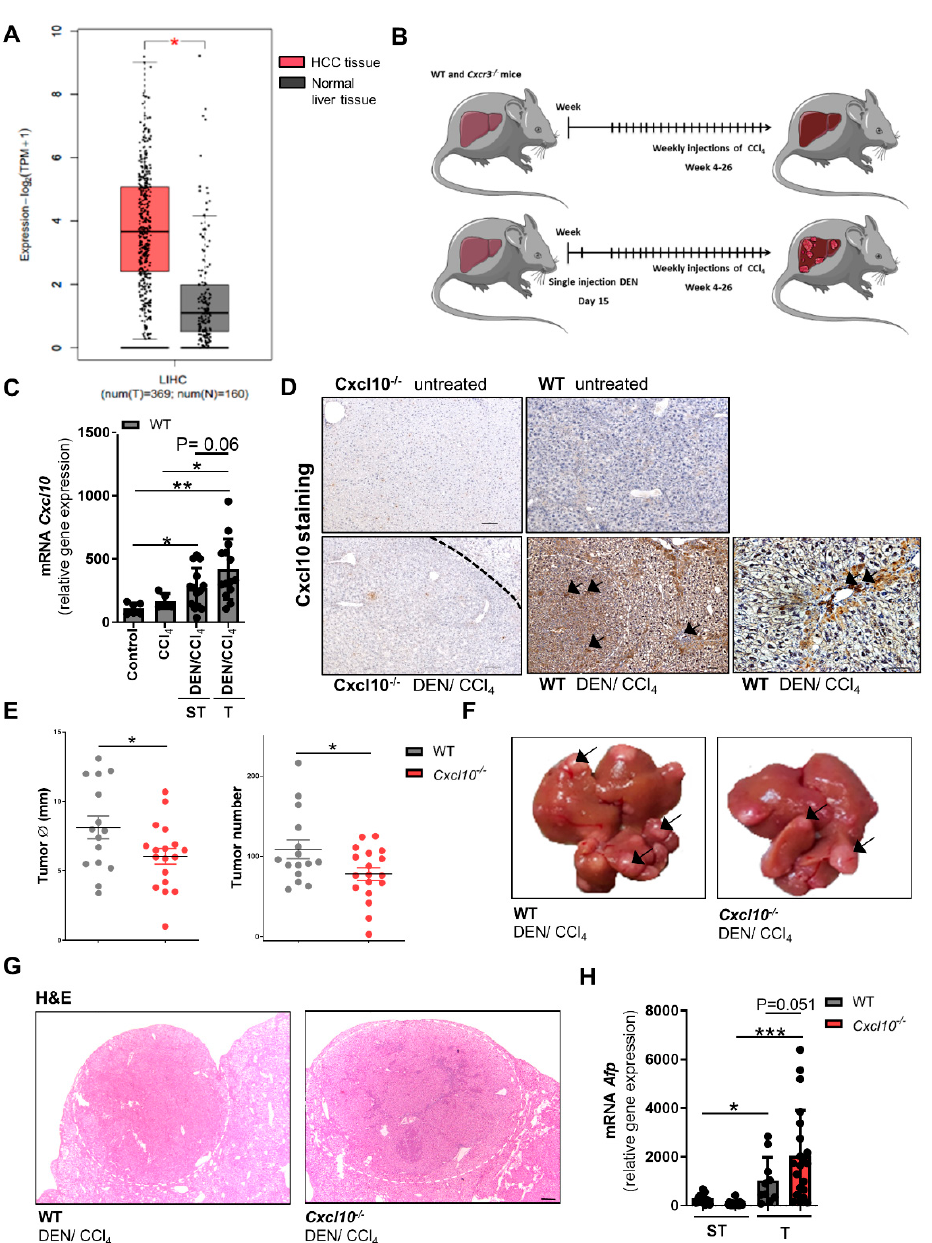
Figure 1. Intrahepatic expression of CXCL10 is elevated in HCC patients and contributes to hepato- carcinogenesis in mice: ( A ) intrahepatic CXCL10 expression in human HCC patient’s gene